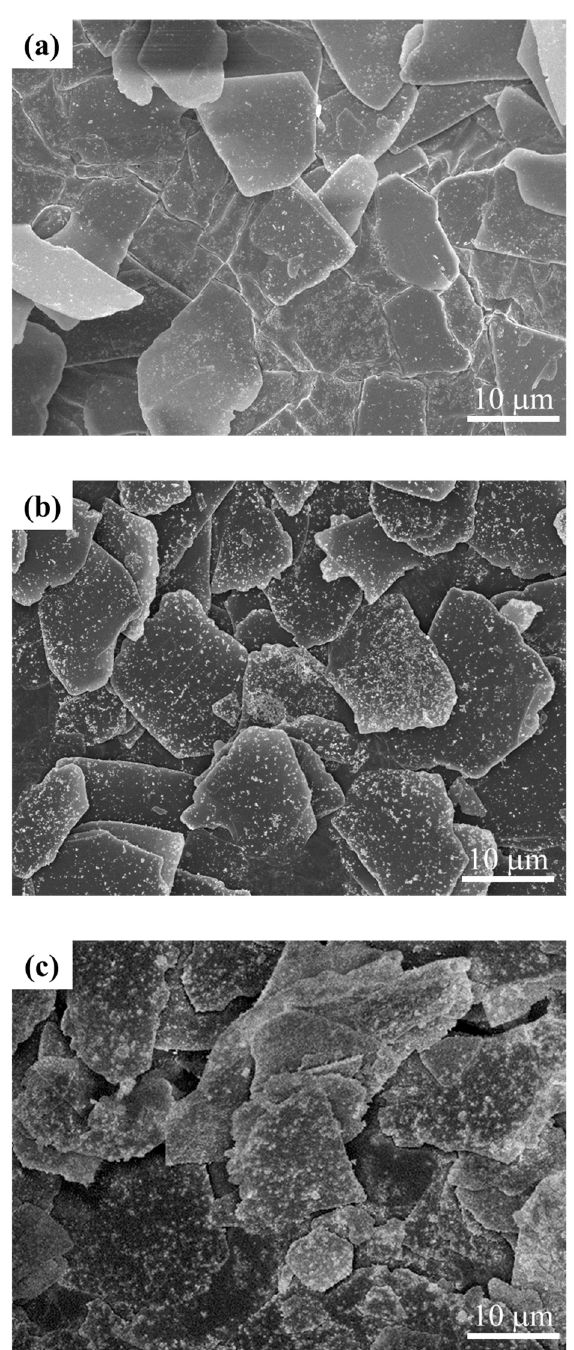
Figure 8. FE-SEM images of Y 2 O 3 :Eu@MF prepared by the variation in stirring temperature, ( a ) 75 °C; ( b ) 85 °C; and ( c ) 95 °C (fixed at pH 8 in H 2 O and Y 2 O 3 :Eu 3+ loading amount 20 wt%).